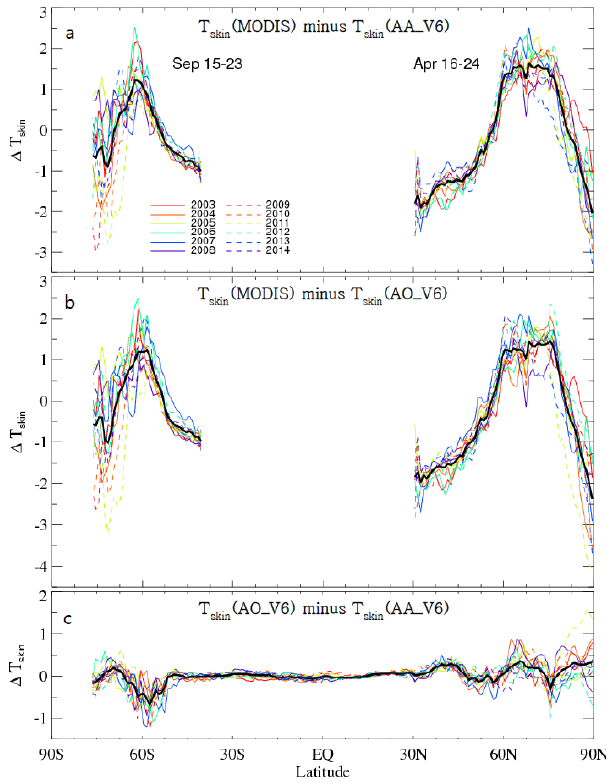
Figure 8. Zonal averaged values of (a) T skin (MODIS) minus T skin (AA_V6), (b) T skin (MODIS) minus T skin (AO_V6), (c) T skin (AO_V6) minus T skin (AA_V6) over the Northern Hemisphere from 16 to 24 April 2003–2014, and over the Southern Hemisphere from 15 to 23 September 2003–2014. The values in each year rep- resent the corresponding color lines. The thick black line indicates the mean difference